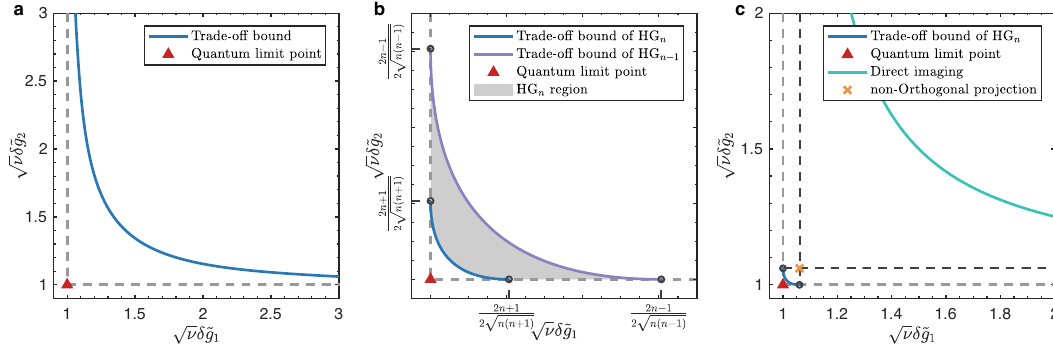
Fig.4|Precisionlimitsoftheincompatibleparameters. Thex-axisandy-axisare separately the normalized estimation errors of parameters g 1 and g 2 . The gray dashed lines are separately the QCR bounds of ~ g 1 and ~ g 2 . The cross point (red triangle in fi gure) of gray dashed lines is the QL point where both parameters achieve the ultimate precision. a Trade-off bound of Gaussian pointer, which is expressed by the blue solid curve, the region below this curve is forbidden by the inequality in Eq. (5). b Trade-off bound of HG pointer. The blue solid curve is the trade-offboundofHG n pointer,thepurplesolidcurveisthetrade-offboundofHG n